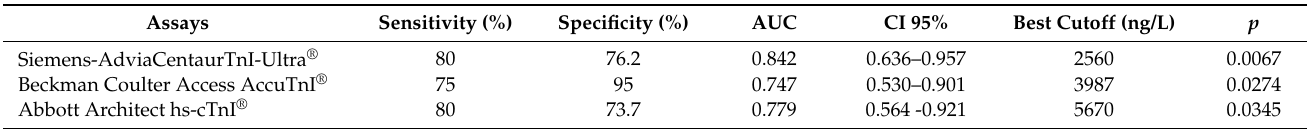
Table 4. ROC Curves of cTnI assays in PCI.